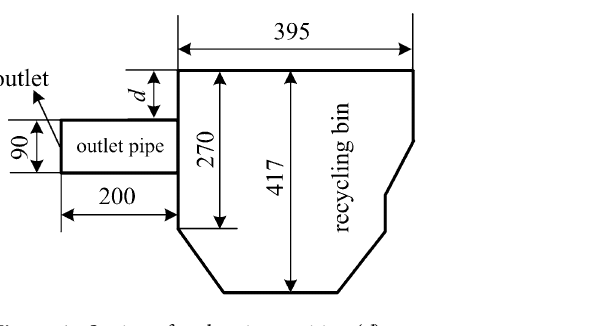
Figure 6. Setting of outlet pipe position ( d